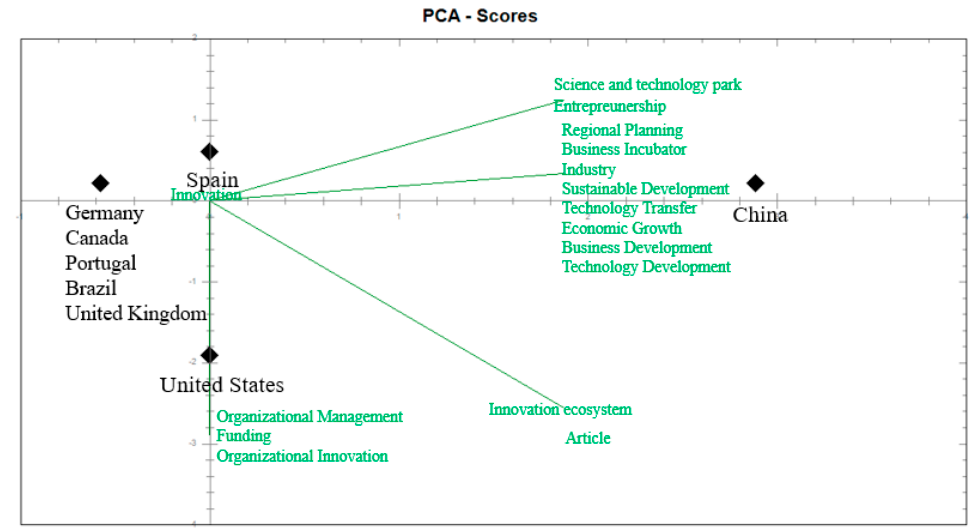
Figure 8. Countries Biplot PCA Scores .